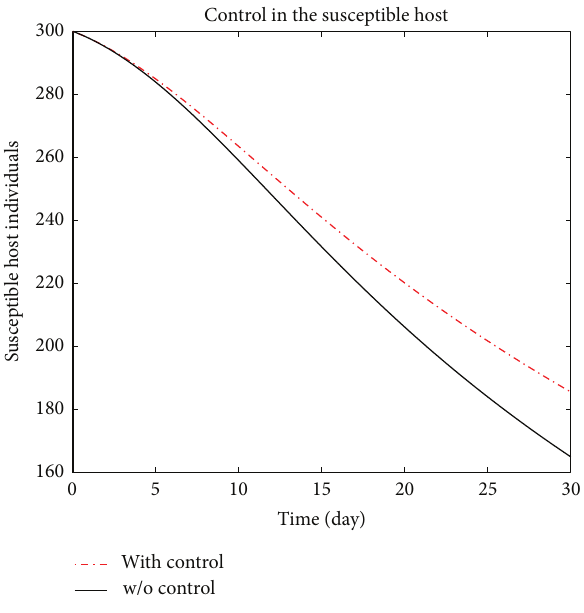
Figure 5: Plot of the number of susceptible hosts with and without control, 𝑢 1 = 0 , 𝑢 2 ̸=0